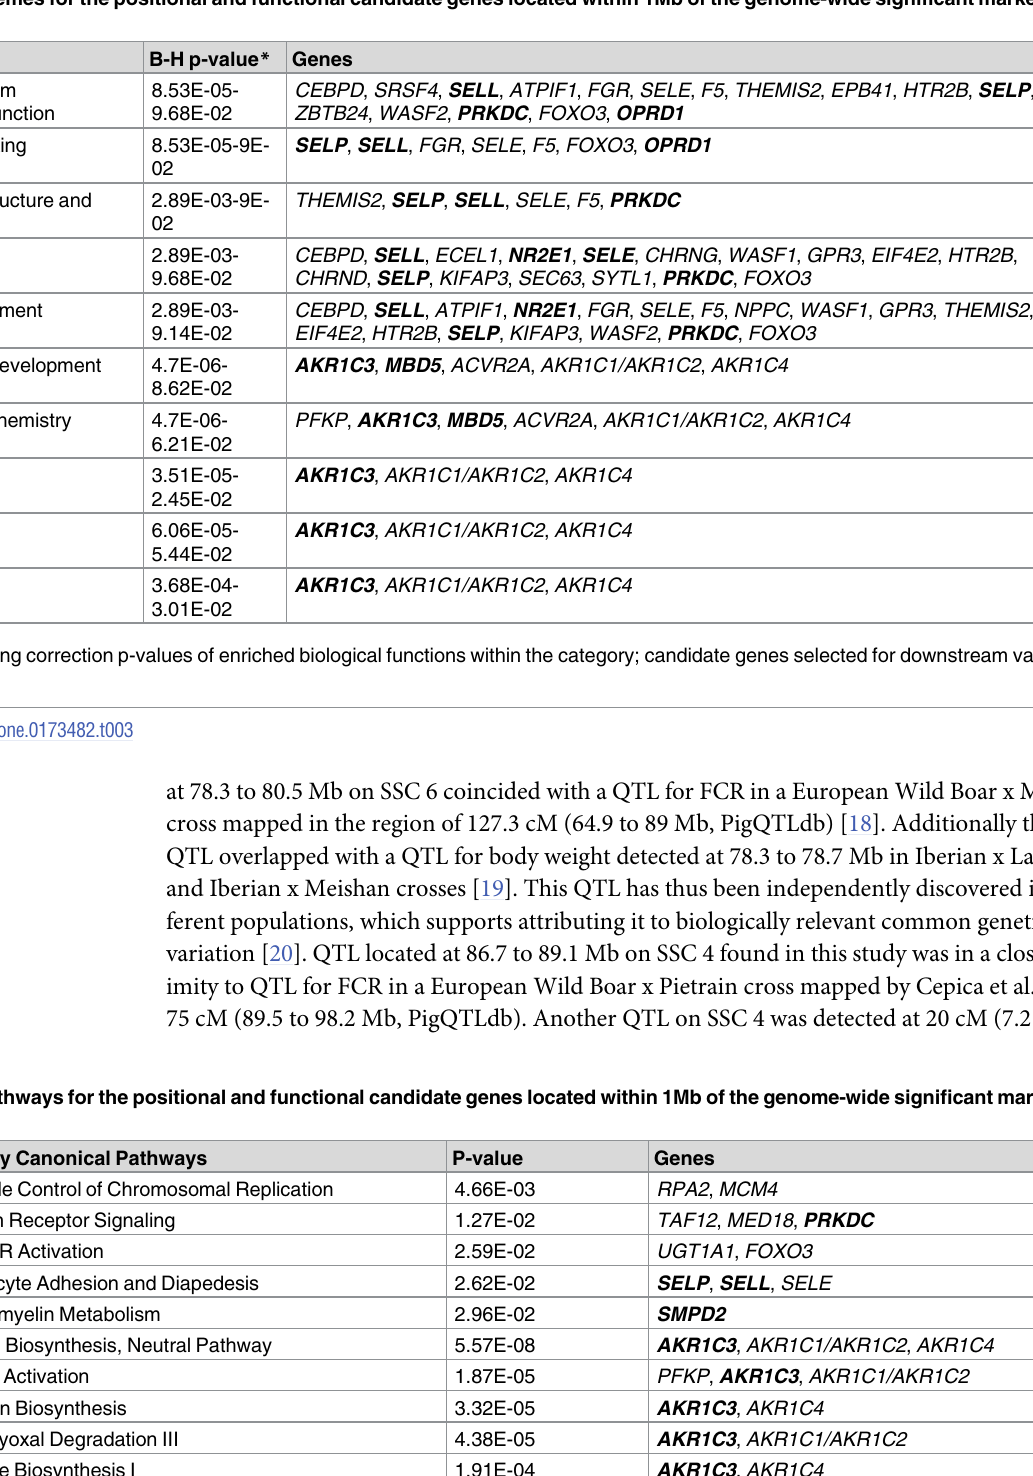
Table 3. Top molecular themes for the positional and functional candidate genes located within 1Mb of the genome-wide significant markersfor EBV of FCR and D110. EBV Category